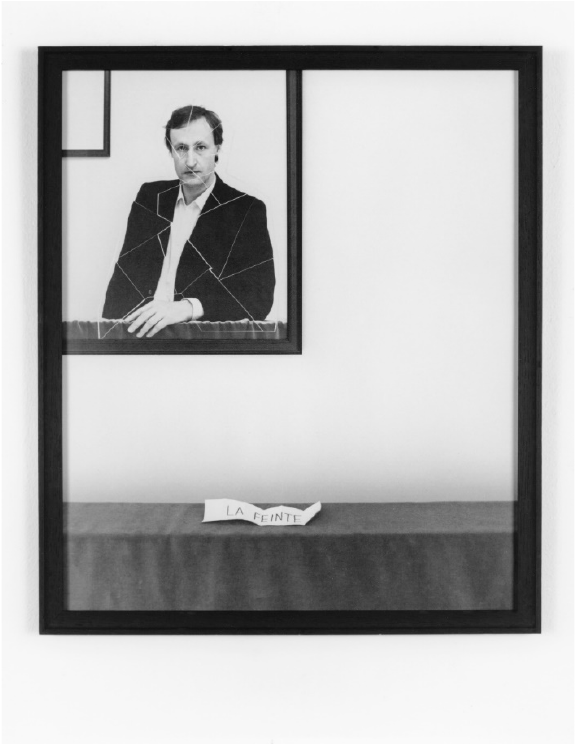
Figure 5. Jan Vercruysse, Sans Titre (La Feinte) , 1982. Photolitho print on paper, 47 × 39.5 cm, framed. Photo: Adam Rzepka. Reprinted with permission from Jan Vercruysse © Jan Vercruysse Foundation.